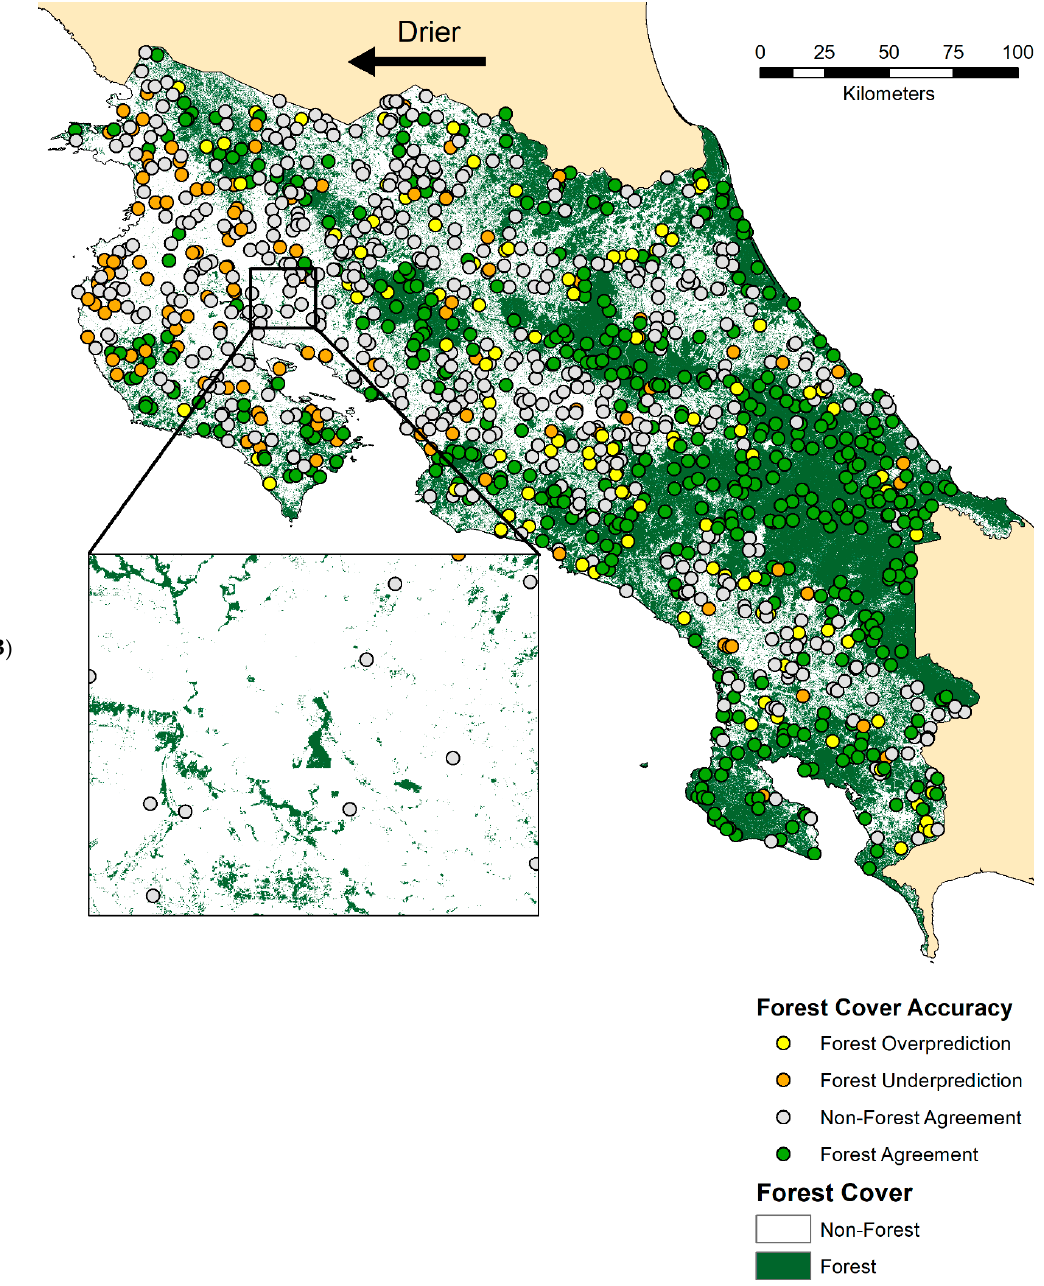
Figure 4. ( A ). Global Forest Change percentage tree cover (2015), showing the spatial distribution of forest cover errors when compared to reference data in Costa Rica ( n = 1154). An 89% tree cover threshold was applied to the GFC and reference dataset to create a binary forest/non-forest classification for accuracy assessment. The colored points reflect the confusion matrix errors, visualized on the map. ( B ). Global Forest Change binary forest/non-forest map (2015), showing the spatial distribution of forest cover errors when compared to reference data in Costa Rica ( n = 1154). An 89% tree cover threshold was applied to the GFC and reference dataset to create a binary forest/non-forest classification for accuracy assessment. The colored points reflect the confusion matrix errors, visualized on the map. The derived GCL global forest map had the highest overall accuracy (82.2 +/ − 2.2%; Table 3, Table A2). The map overpredicted forest cover (a user’s accuracy for forest of 77%). However, the spatial distribution of errors appeared to be uniform across the country, with no apparent